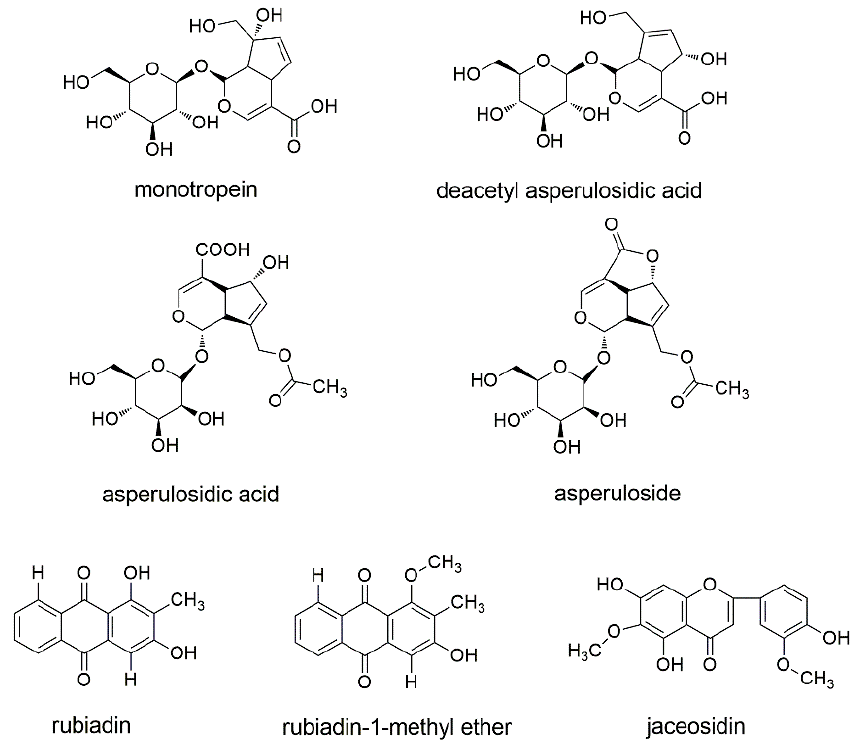
Figure 1 . Chemical structures of the six compounds and jaceosidin (internal standard, IS). Figure 1. Chemical structures of the six compounds and jaceosidin (internal standard,